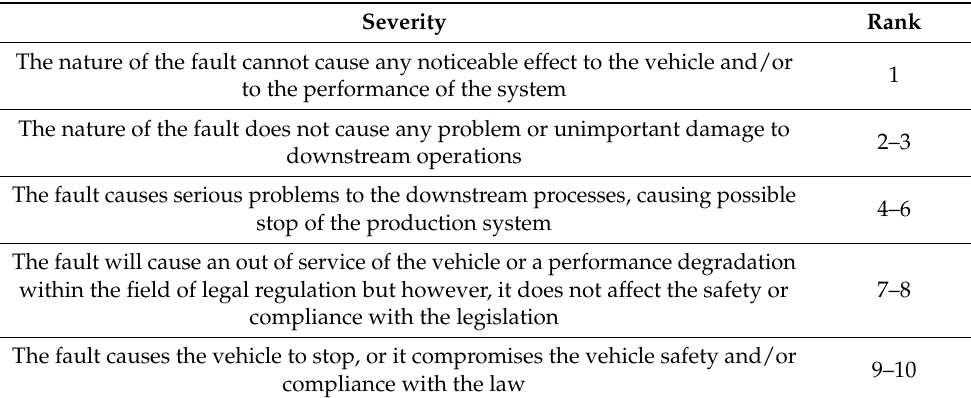
Table 6. Ratings for the severity of a failure